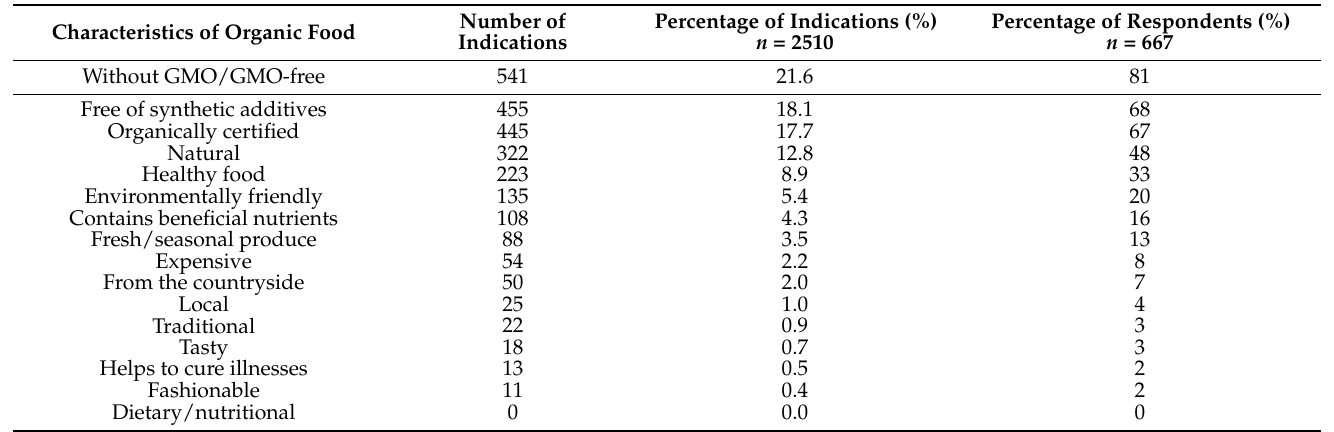
Table 8. Characteristics of organic food as perceived by the respondents (multiple choice).